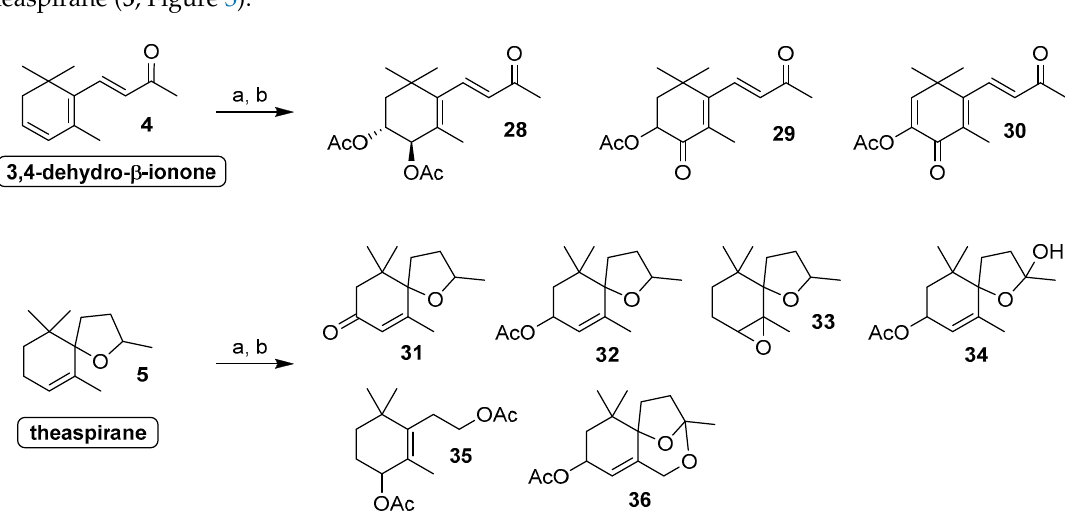
Figure 3. Compounds obtained through biotransformation of 3,4-dehydro- β -ionone and theaspirane by means of the fungal strains employed in the present study. Reagents and conditions : ( a ) fungal strain, MEM, aerobic conditions, 140 rpm, 20 or 25 °C, 14–20 days; ( b ) Ac 2 O/Py, DMAP catalyst, rt, 6 h.